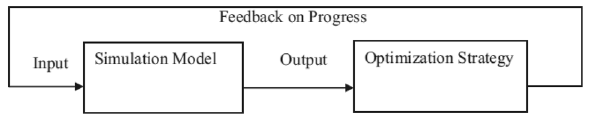
Figure 1. Interfacing a simulation model and an optimization